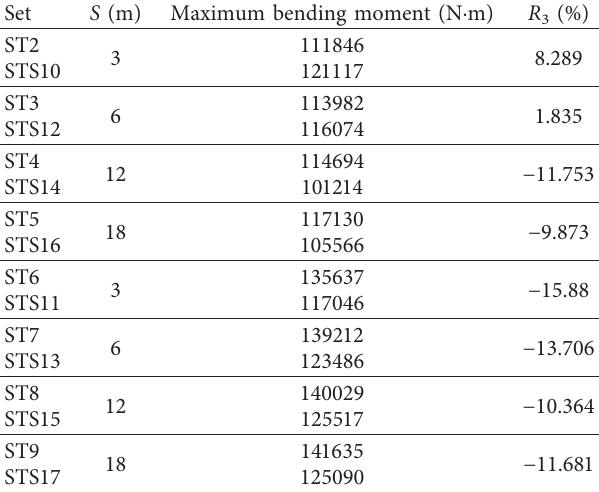
Table 10: Maximum bending moment of the tunnel structure under various conditions. Set S